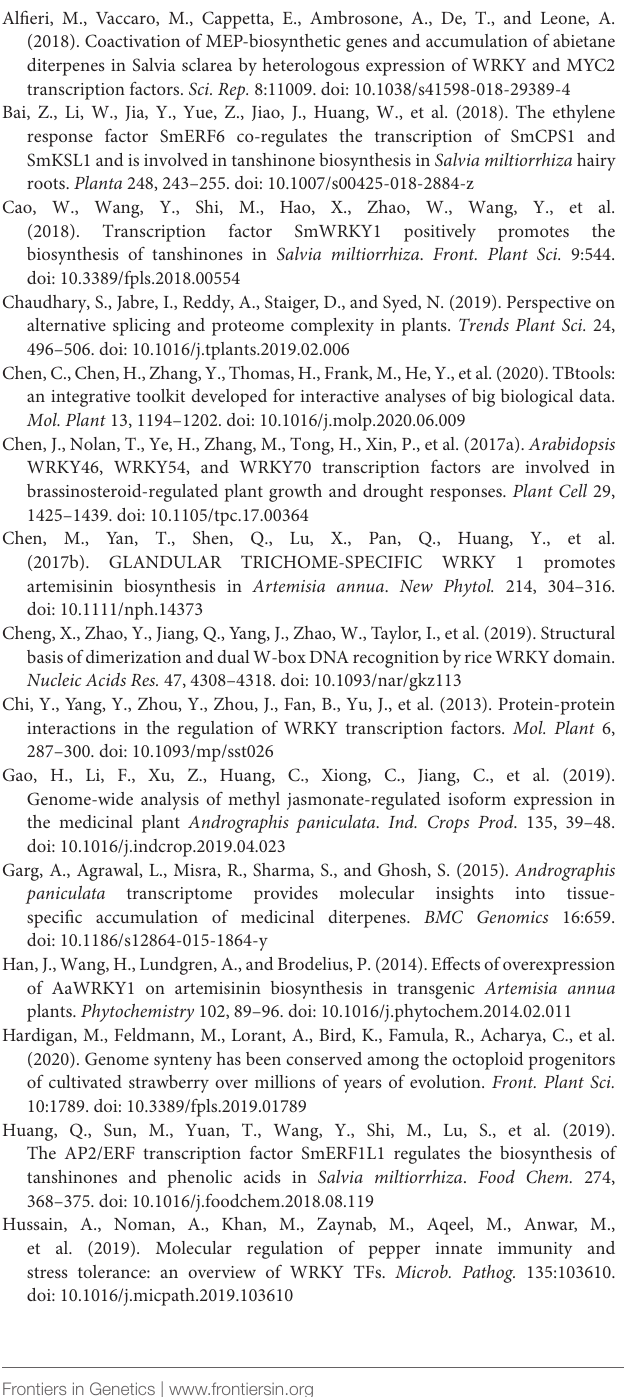
Supplementary Table 3 | Conserved motifs identified in WRKY transcription factors from A. paniculata by MEME analysis. Supplementary Table 4 | The average FPKM values of 58 WRKY genes in different organs and MeJA-treated seedlings. Supplementary Table 5 | Regulatory elements targeted by WRKY TFs in the promoters of the enzyme-coding genes of the andrographolide biosynthesis